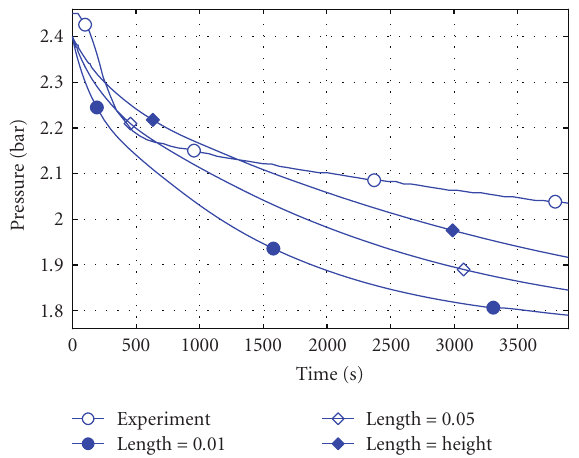
Figure 10: Pressure evolutions with di ff erent characteristic length